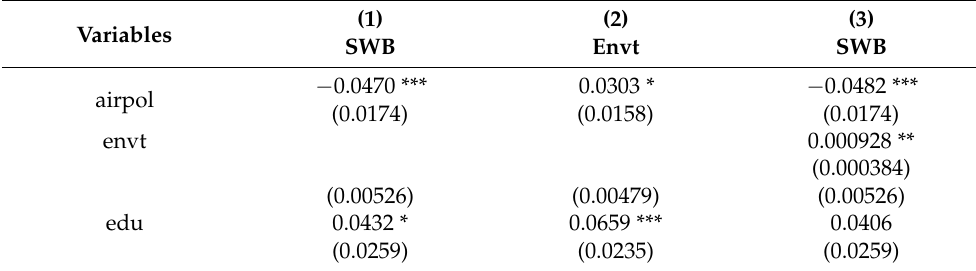
Table 9. Robustness